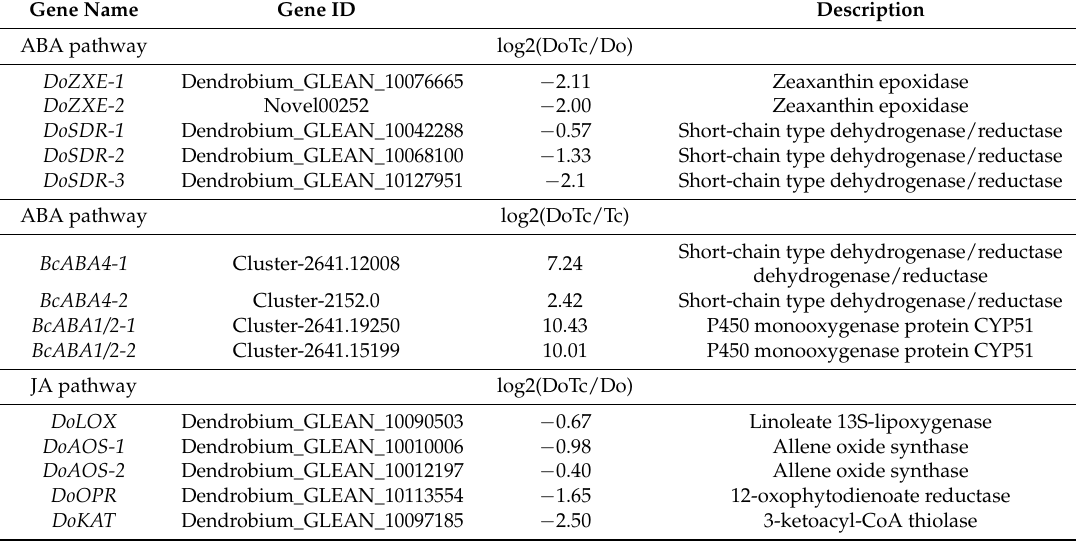
Table 1. The DEGs in the DoTc vs. Do and DoTc vs. Tc comparisons involved in the ABA